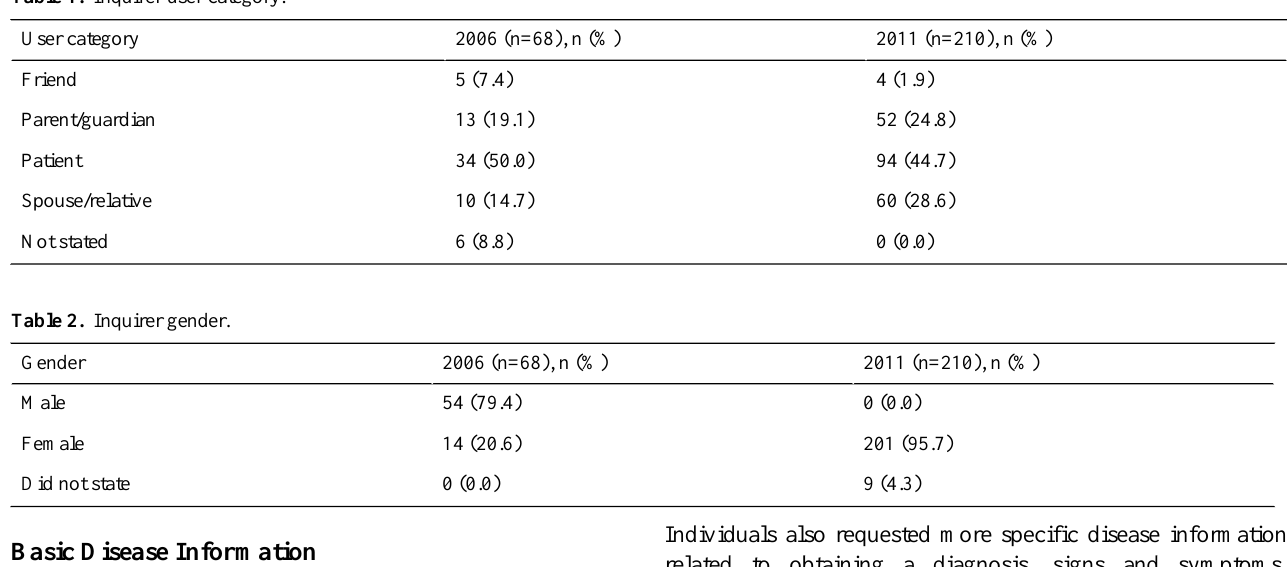
Table 1. Inquirer user category.